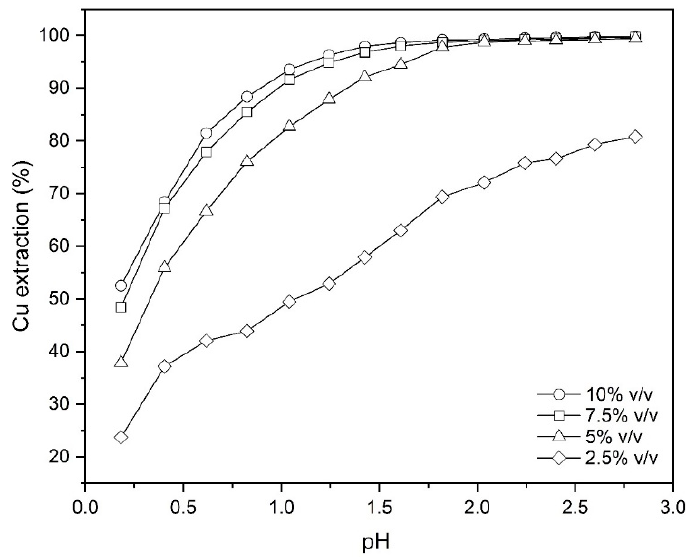
Figure 1. The effect of Mextral 5640H and pH on the Cu extraction (T = 25 °C, O/A = 1 and t = 30 min).